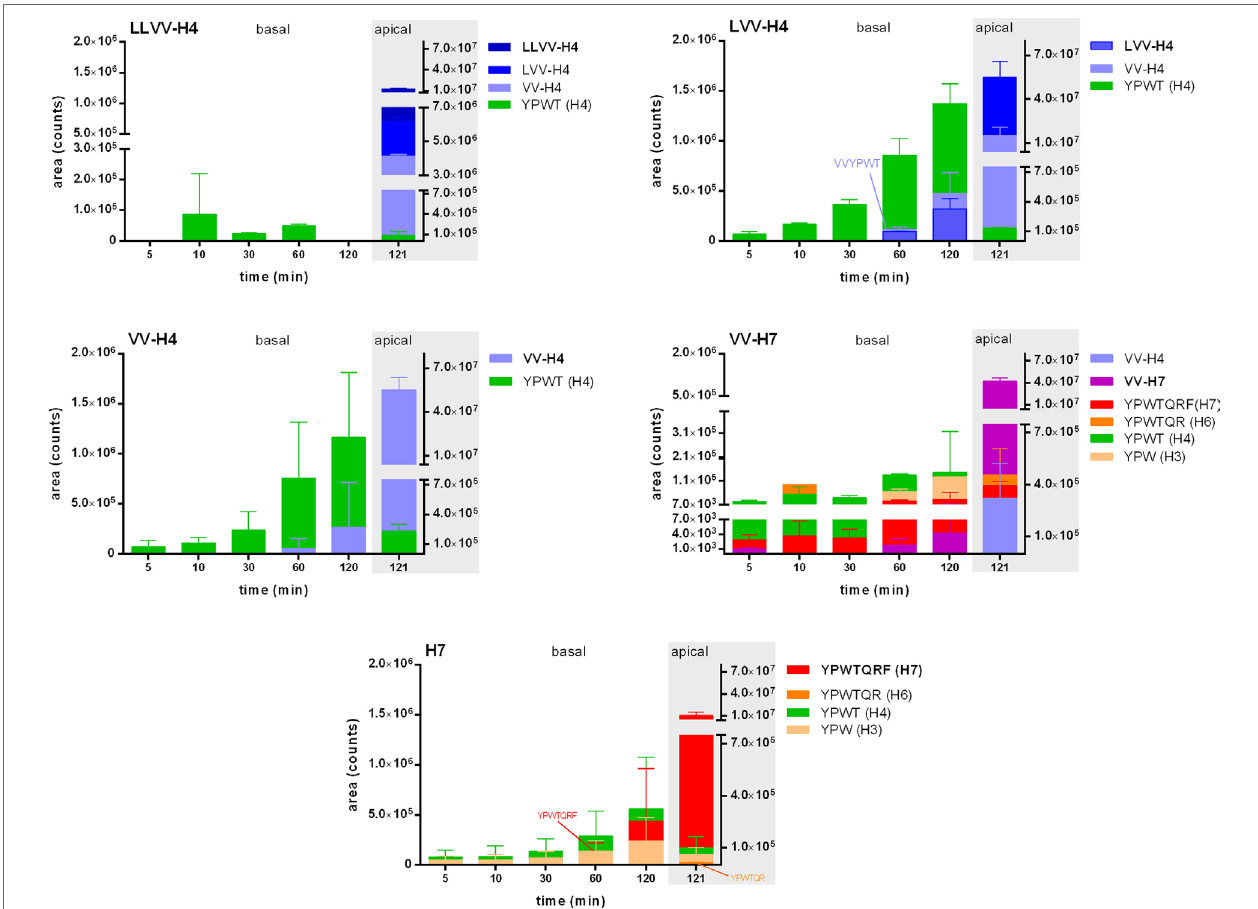
FigUre 2 | Release kinetics of the five hemorphins fragments in the basal side of a Caco-2 monolayer as an intestinal barrier passage model. The metabolism of the five hemorphins was evaluated by monitoring the apparition of peptide fragments issued from the opioid peptides by selected ion monitoring analyses in the basal chamber at five time points. The presence of these fragments was also investigated in the apical chamber after the 2 h incubation to determine whether these fragments were the results of the passage through the Caco-2 monolayer. Data are expressed as mean ± SD ( n =